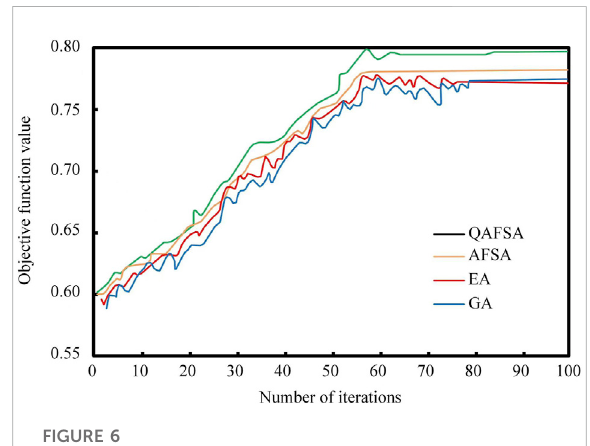
FIGURE 6 Convergence performance of multi-user system resource allocation strategy.